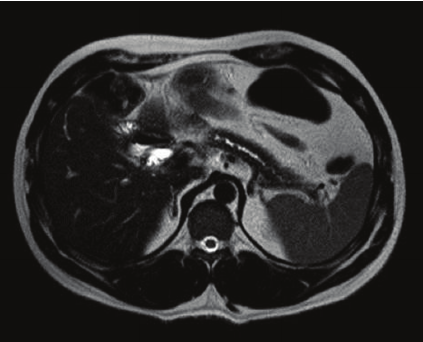
Figure 1: MRI shows main pancreatic duct dilation and